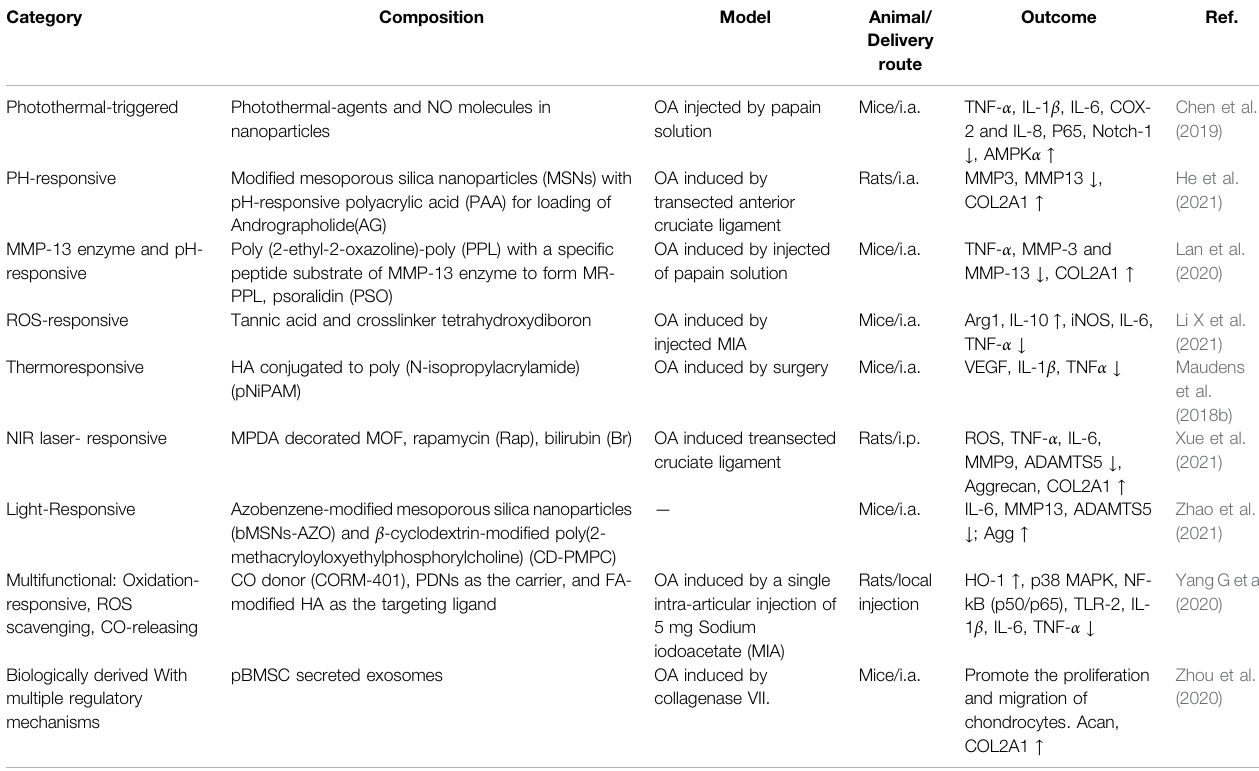
TABLE 3 | Functional nanotherapeutic strategies for OA.